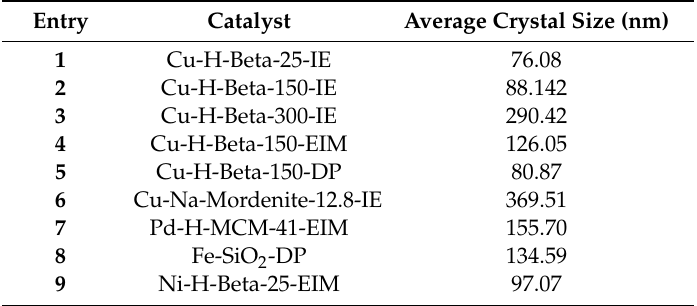
Table 4. Average crystal size of Cu-H-Beta-25-IE, Cu-H-Beta-150-IE, Cu-H-Beta-300-IE, Cu-H-Beta-150-EIM,